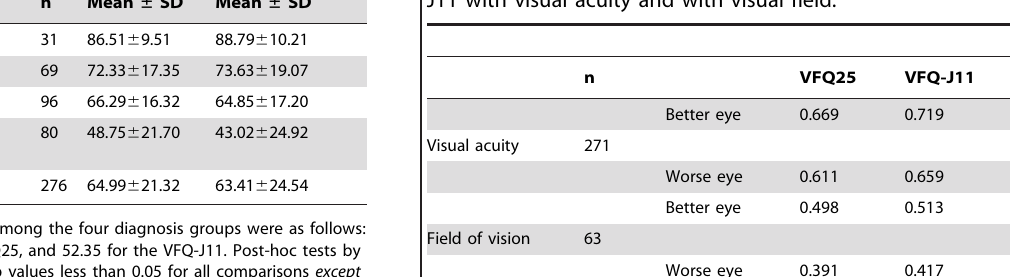
Table 4. Correlations of scores on the VFQ25 and the VFQ- J11 with visual acuity and with visual